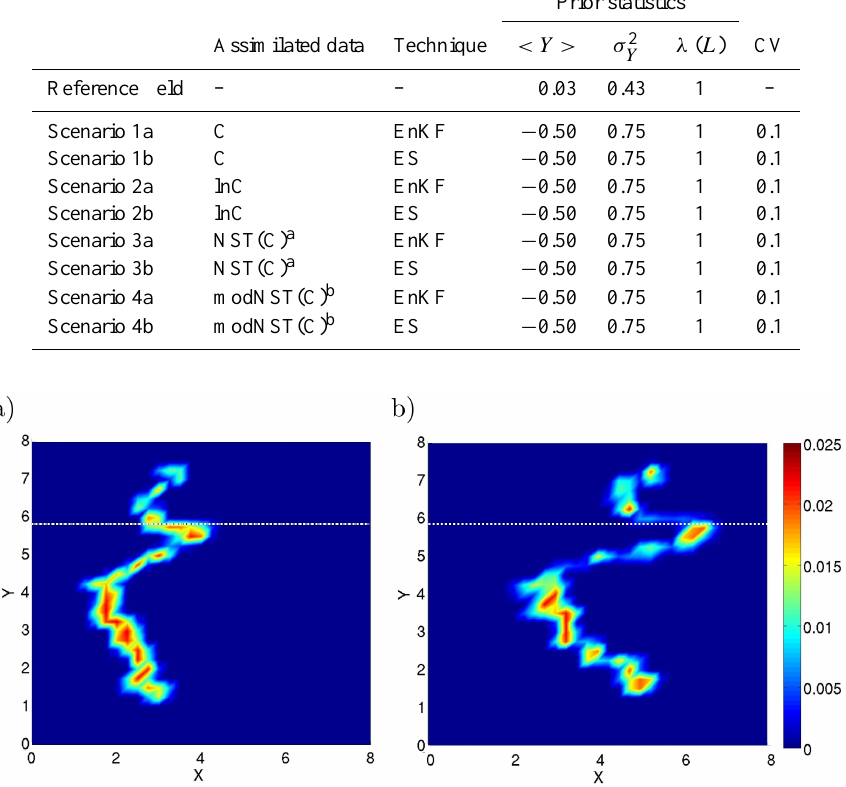
Fig. 2. Plume evolution in the reference field at (a) t =2 T and (b) t =4 T . The color bar denotes dimensionless concentration C . Dotted lines show the direction along which the cross-correlation structure between Y and C is evaluated.